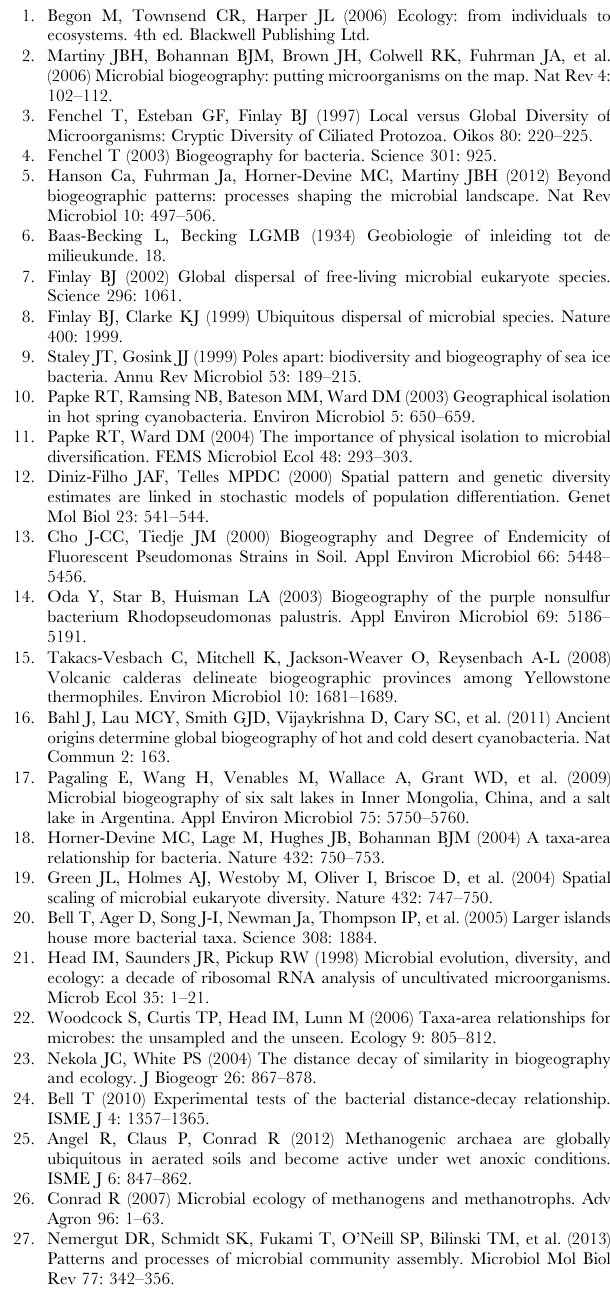
Table S1 Tentative genetic affiliation of the OTUs. For the three studied genes there are in the literature some genetic affiliation with different phylogenetic groups, we show some of these in this table. * The affiliation with the phylogenetic groups was based on literature data that used the same primers and restriction enzymes for TRFLP. All the affiliations are only tentative, and can only be interpreted as the probable main groups of the lake sediment